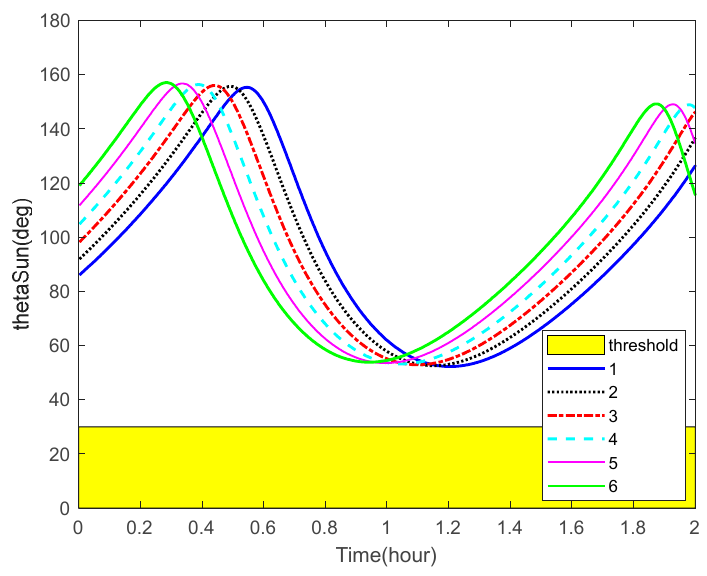
Figure 11. Sun-aircraft-target angles and the corresponding bounds.